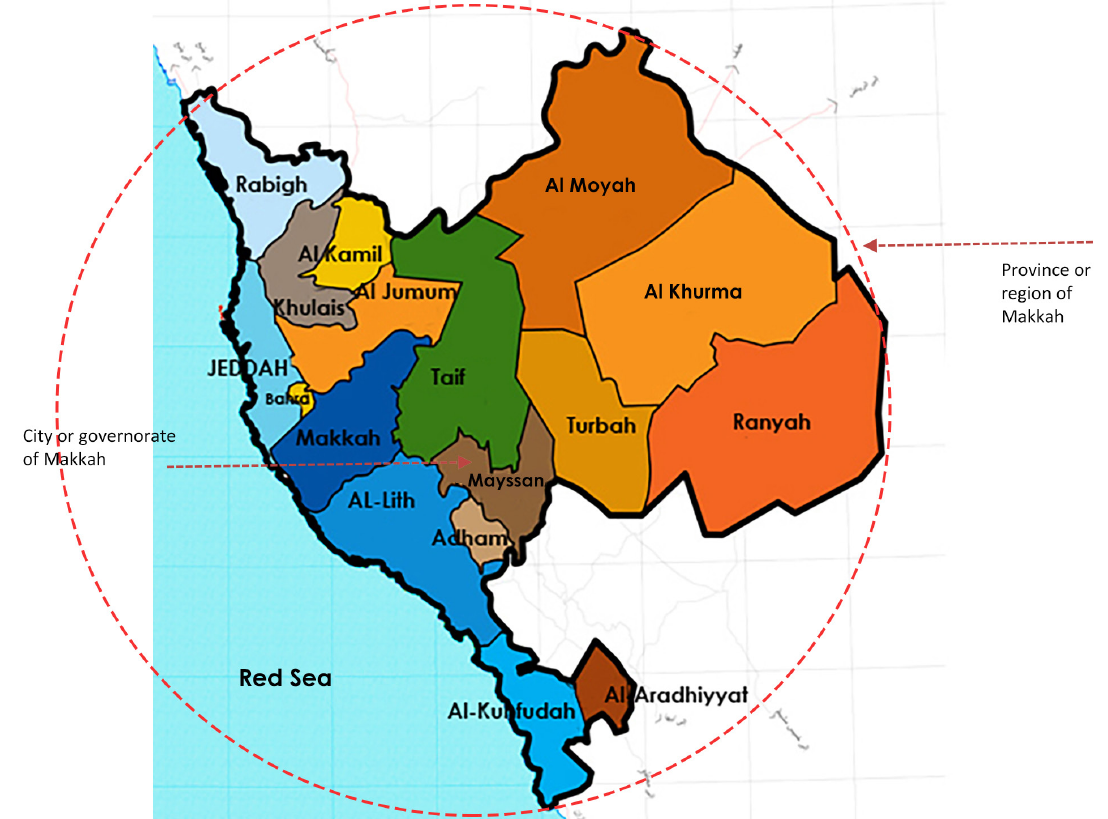
Fig. 2. Map of the Makkah Province.